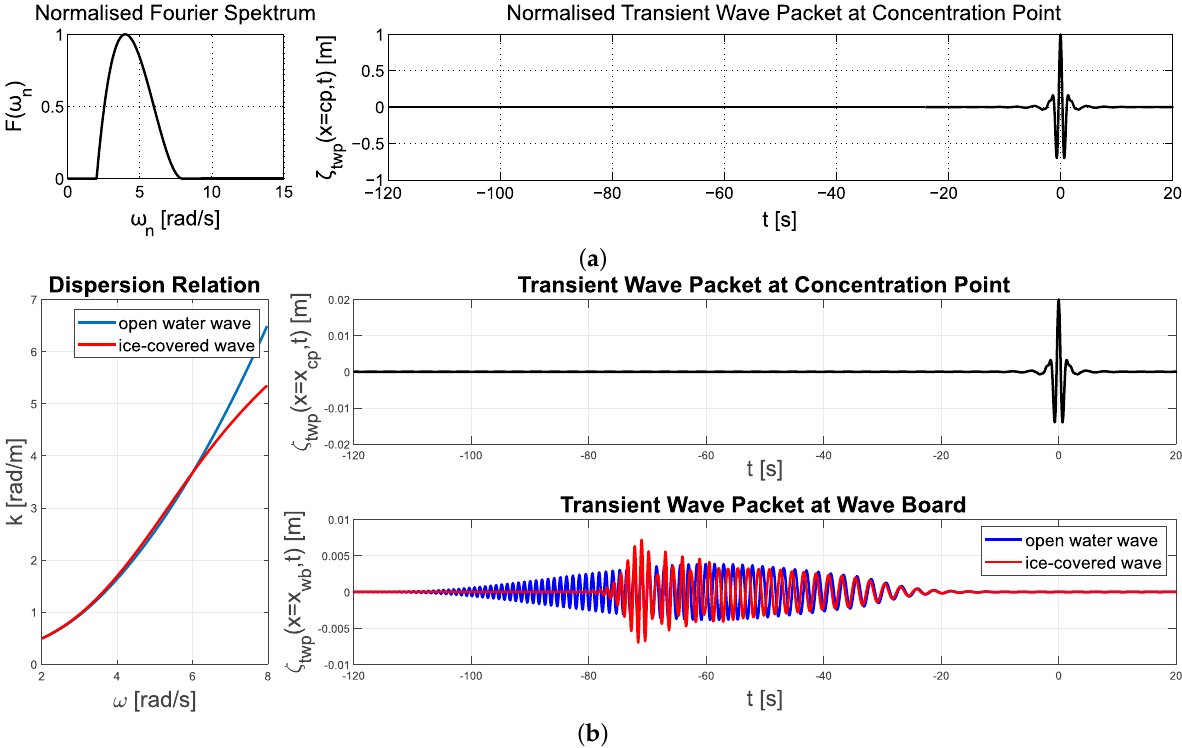
Figure 2. Overview of the TWP concept. ( a ) Theoretical TWP concept—normalised TWP Fourier spectrum ( left ) and normalised TWP in time domain at concentration point ( right ). ( b ) Application TWP concept—TWP at concentration point ( top right ) and corresponding surface elevation at the wave board ( bottom right ). The surface elevation based on open water dispersion is shown by the blue curve and the consequences for wave propagation due to the presence of the ice sheet are illustrated by the red curve. The comparison of the dispersion relation between open water (blue curve) and the ice sheet (red curve) is shown in the left